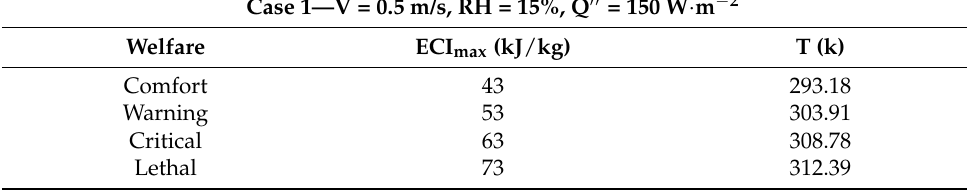
Table 2. Results of BO inverse mapping to obtain ambient relative humidity and temperature for various ECI max